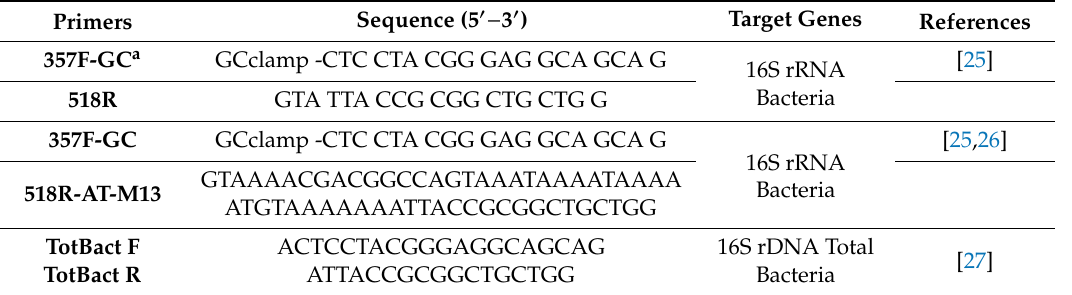
Table 2. Primers used for PCR-DGGE, DGGE band re-amplification and for total bacteria quantification. (cid:48) − 3 (cid:48) ) Target Primers Sequence (5